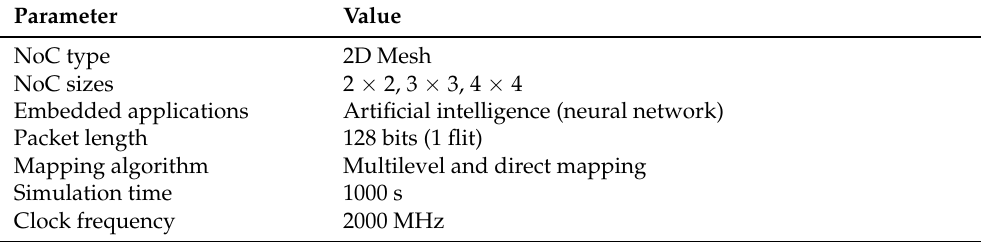
Table 3. List of